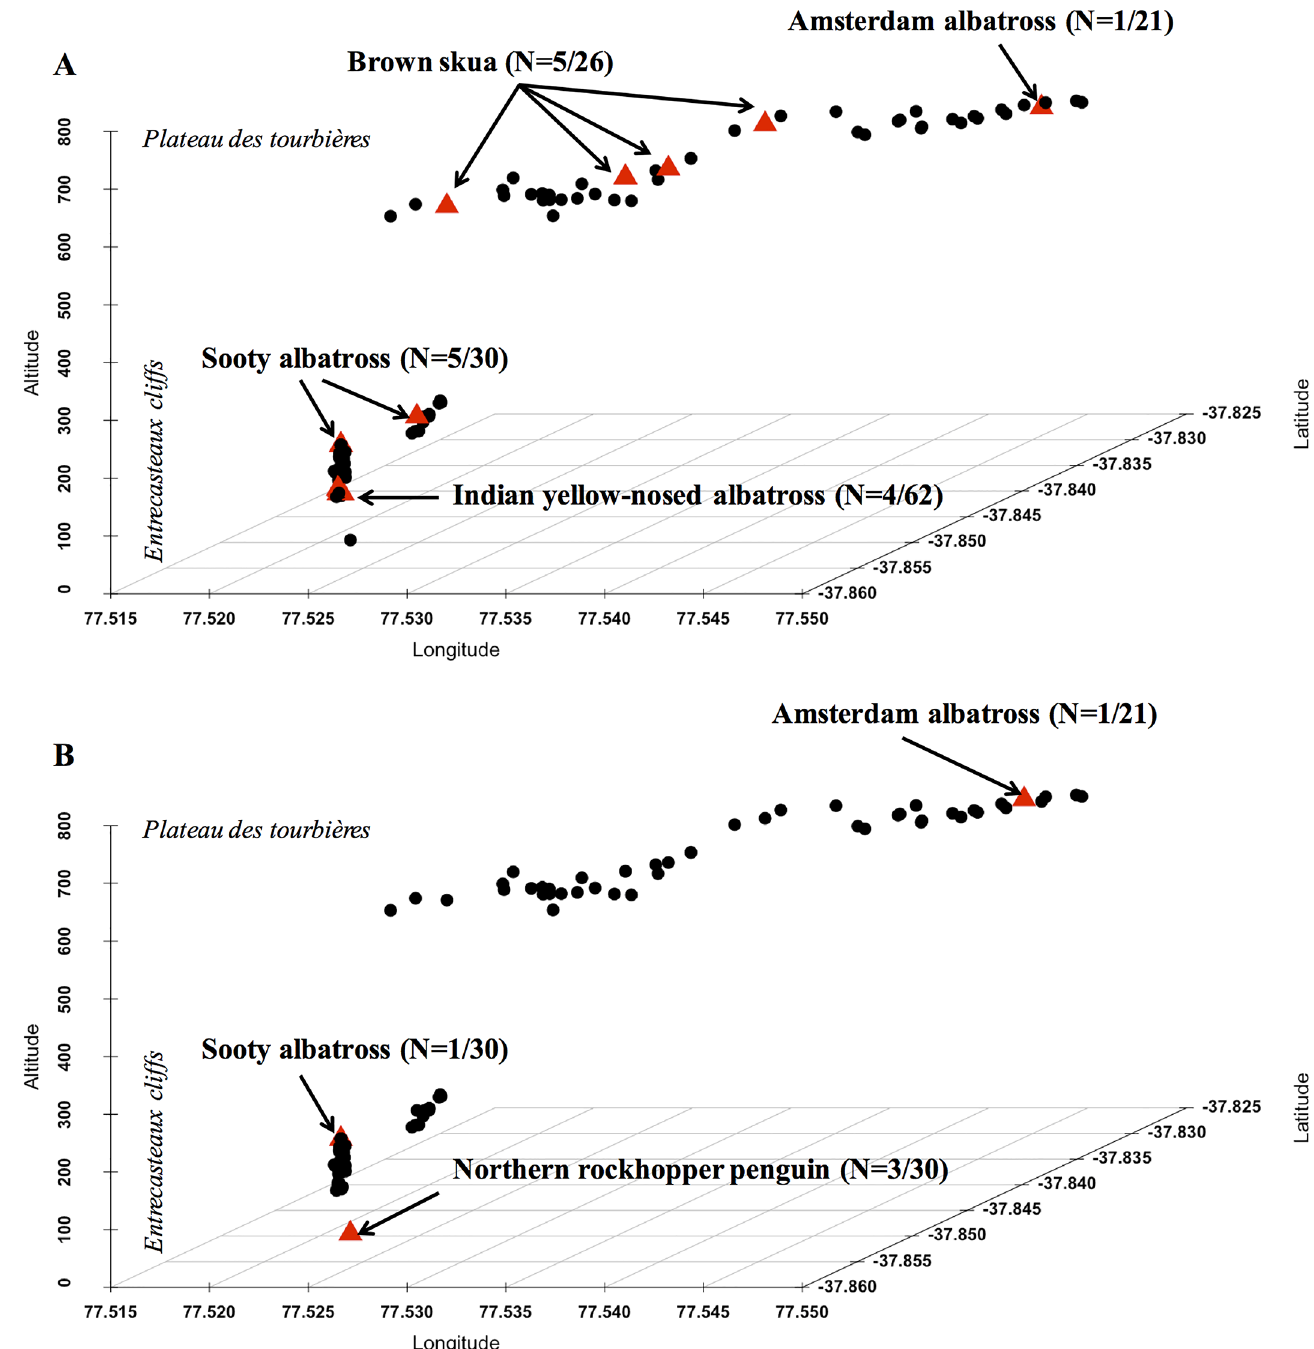
Fig 2. Spatial locations of the individual seabirds which tested positive (red triangles) or negative (black dots) for (a) Pasteurella multocida and (b) Erysipelothrix rhusiopathiae on Amsterdam Island. Horizontal axes represent longitude (x-axis) and latitude (z-axis); the vertical axis (y-axis) is the elevation of the nests above sea level. The Amsterdam albatross and the brown skua breed on the Plateau des Tourbières, while the Indian yellow-nosed and sooty albatrosses and the northern rockhopper penguin breed in the Entrecasteaux